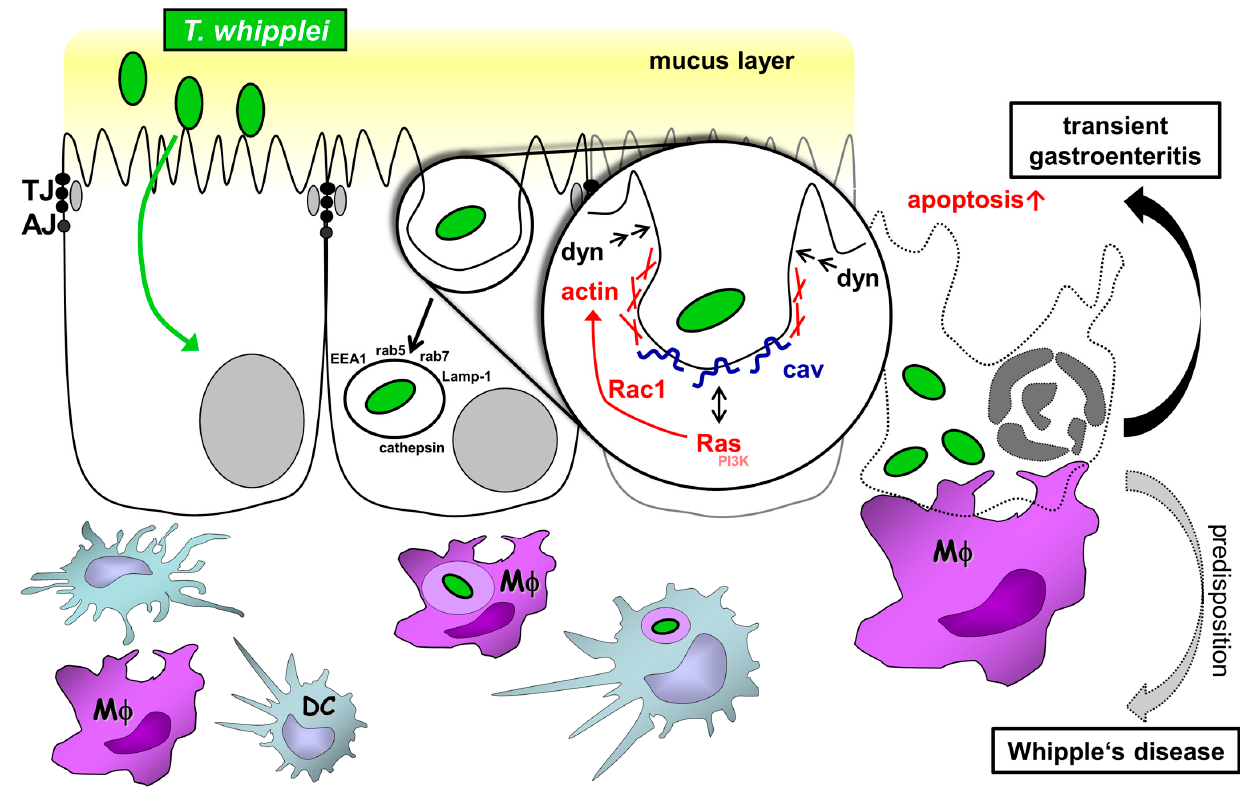
Figure 6. Scheme of the proposed mechanism for T. whipplei uptake and T.-whipplei -induced barrier defect. Tropheryma whipplei ( TW ) are Gram-positive rod-like bacteria that cause Whipple’s disease.